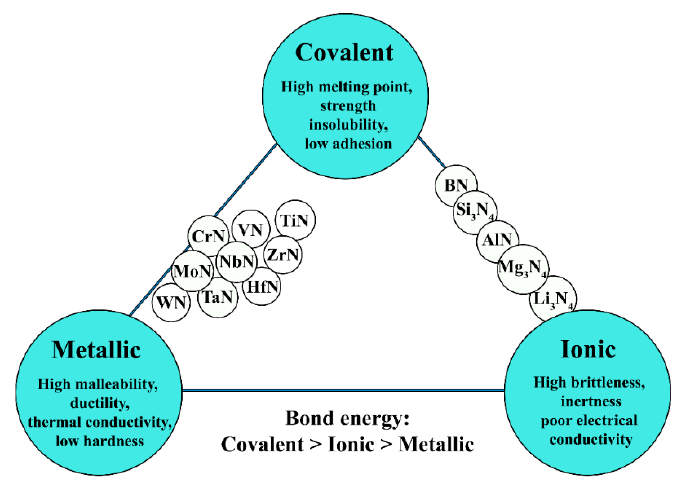
Figure 1. Chemical bonds and properties of some nitrides. Adapted from [29] .